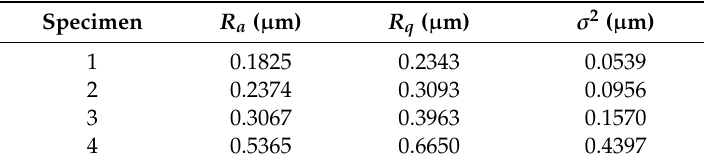
Table 1. Characterization parameters of specimen surface morphology.